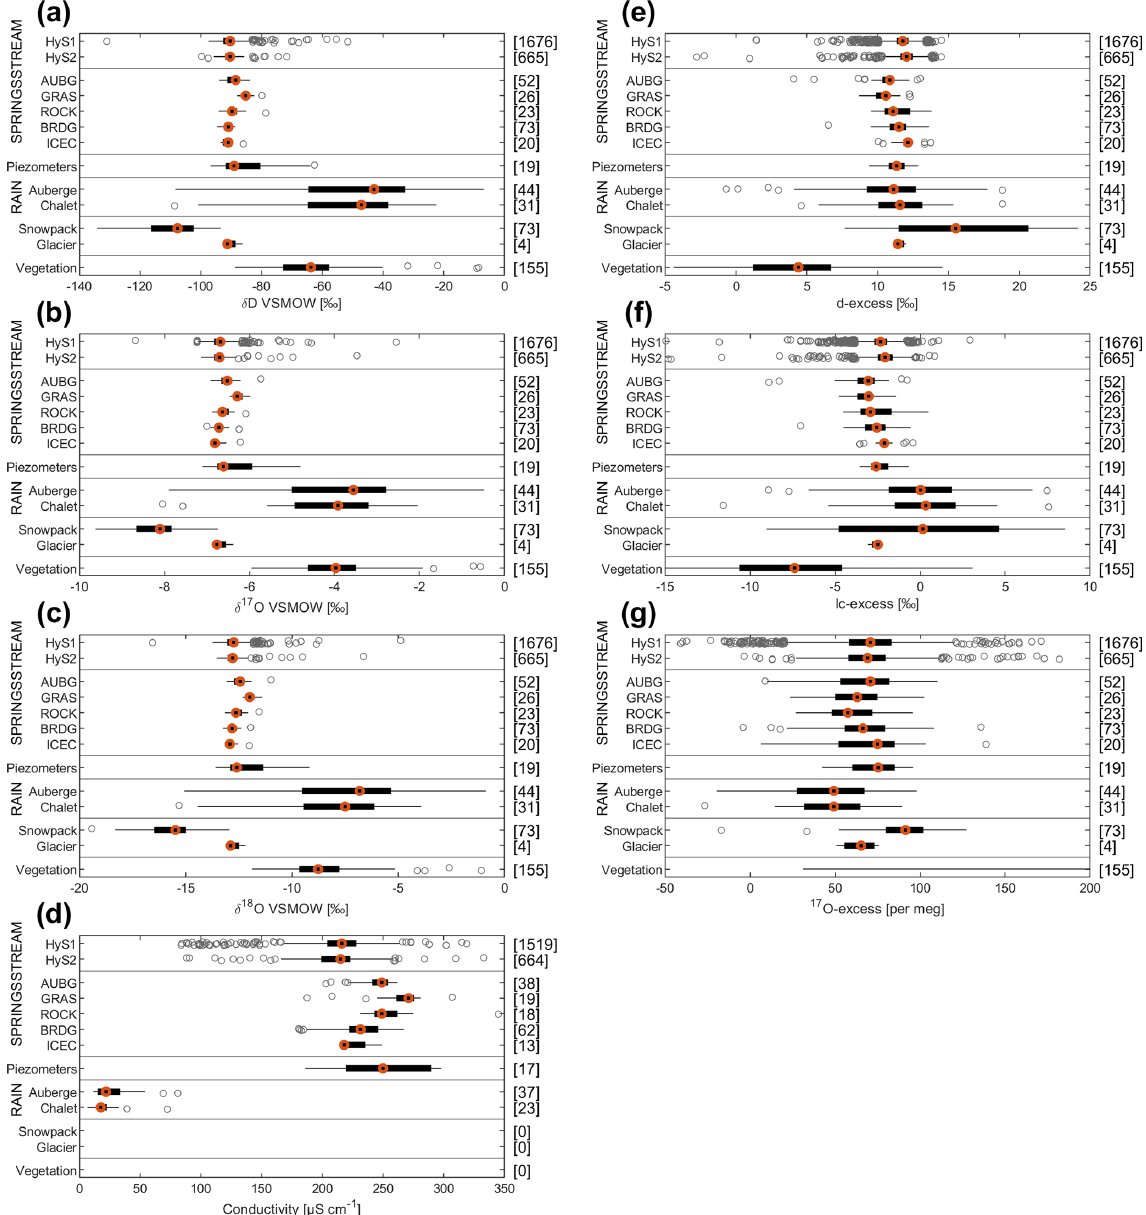
Figure 4. Range of δ 2 H, δ 17 O, δ 18 O, conductivity, d-excess, lc-excess, and 17 O-excess for stream, springs, groundwater, rainfall, snowpack, glacier, and vegetation water samples. For measurements of the same water type (STREAM, SPRINGS, and RAIN), the lowest sampling elevation is given on top and the highest on the bottom. The left and right ends of each box show the 25th and 75th percentiles, and the middle point is the median. The whiskers go up to 1.5 times the interquartile range; values beyond the whiskers (outliers) are marked with circles. The values on the right y axis of the figures are the number of samples in each category. Note that there are no conductivity measurements for snowpack and vegetation water samples. For 17 O-excess, the values of vegetation samples are out of the box (median 572‰; 25th and 75th percentiles are 374‰ and 742‰, respectively, and whiskers are from 31‰ to